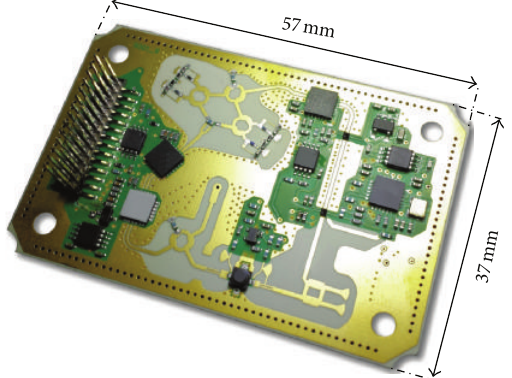
Figure 12: Photo of the radar front-end.